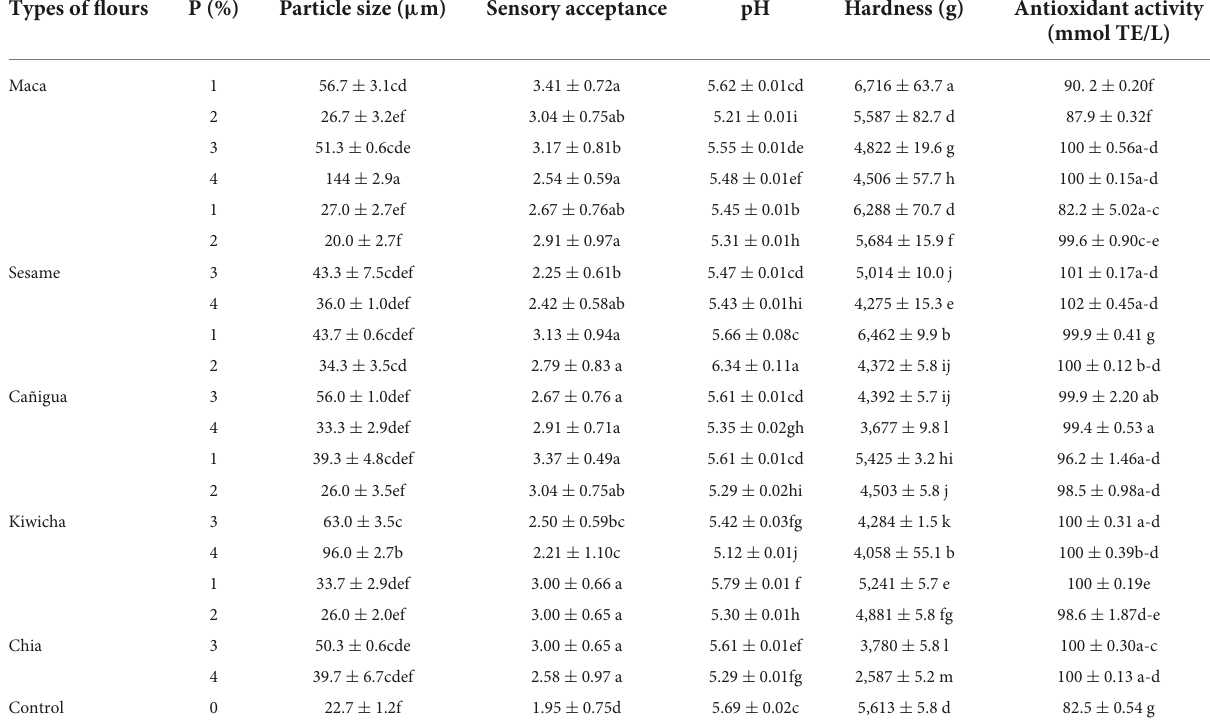
TABLE 1 Results of particle size, sensory acceptance, hydrogen potential, hardness and antioxidant activity of dark chocolates enriched with 5 types of high-nutritional value flours, in different percentages. Types of flours